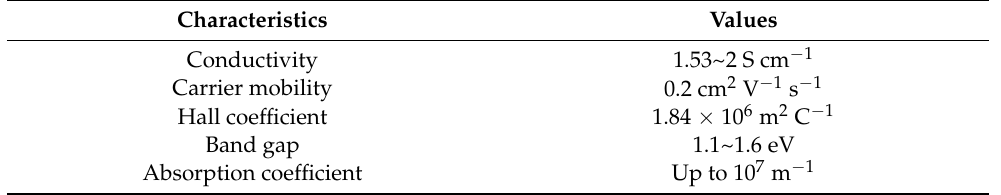
Table 1. General characteristics of delafossite-structured CuFeO 2 [1–3,8,9,16].